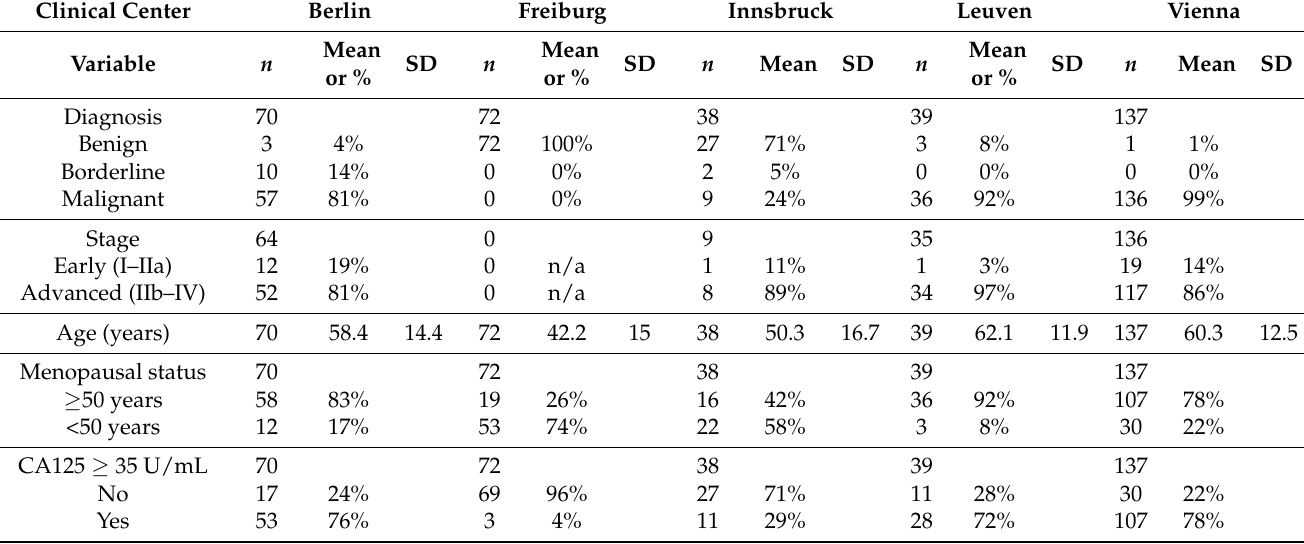
Table A2. Summary statistics broken down by center.